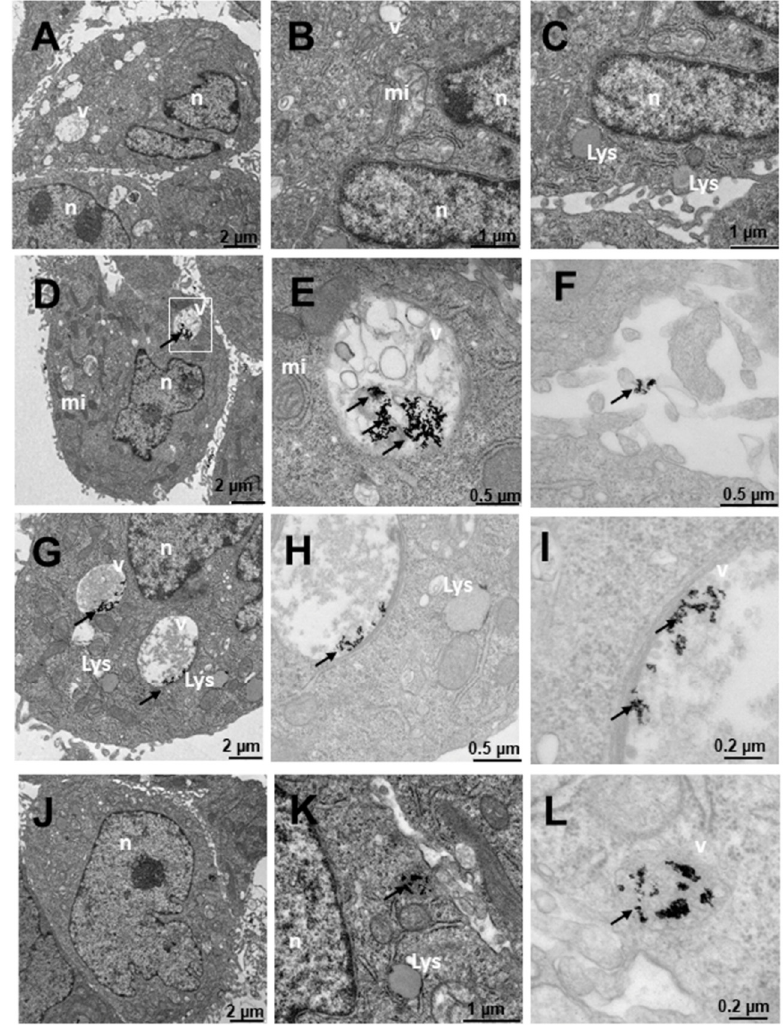
Figure 12. Transmission electron microscopy (TEM) photomicrographs of control cells without treatment ( A – C ), compared to Au@16-Ph-16 (N 3 ) ( D – F ), Au@16-Ph-16/DNA/Doxo (C 3 ) ( G – I ) and Au@16-Ph-16/DNA/Doxo + Au@16-Ph-16 (C 3 + N 3 ) ( J – L ) at 24 h, in HepG2 cells, derived from non- tumorigenic hepatoblastoma, considered as control cells. The dense bodies indicated by an arrow are compatible with the gold core of the nanoparticles. Abbreviations: Lys—lysosome, mi—mitochondria, n—nucleus and v—vesicles.